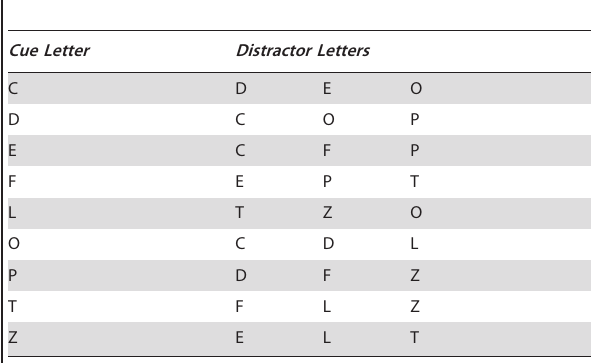
Table 3. Cues and distractors.